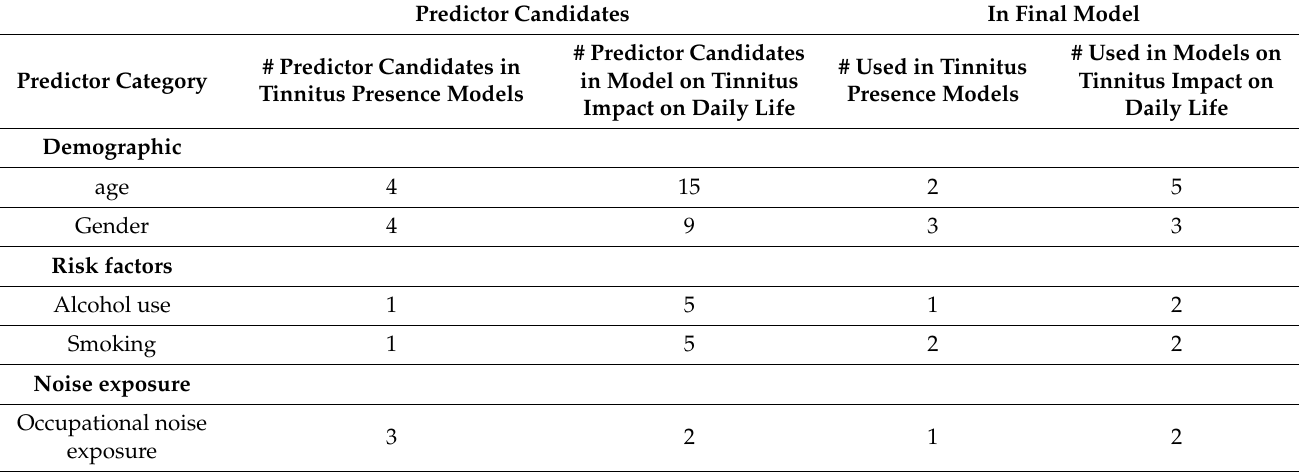
Table 4. Most frequently used predictor candidates and included